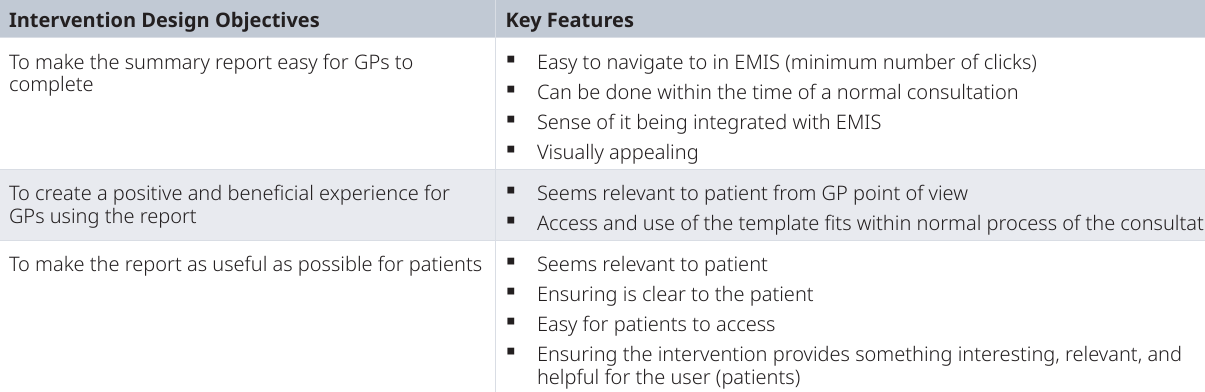
Table 4. Guiding principles – consultation summary